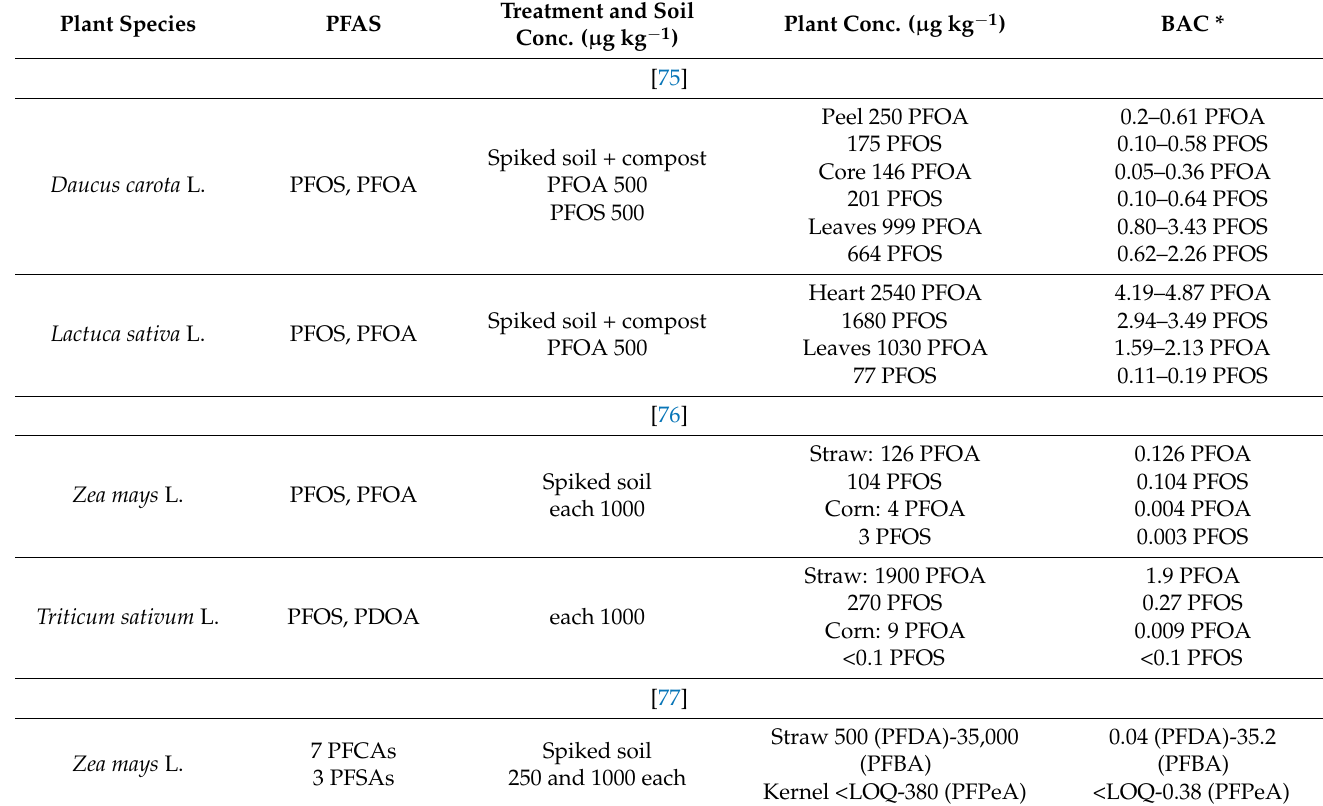
Table 3. Response of plants to PFAS compounds * in pot experiments.